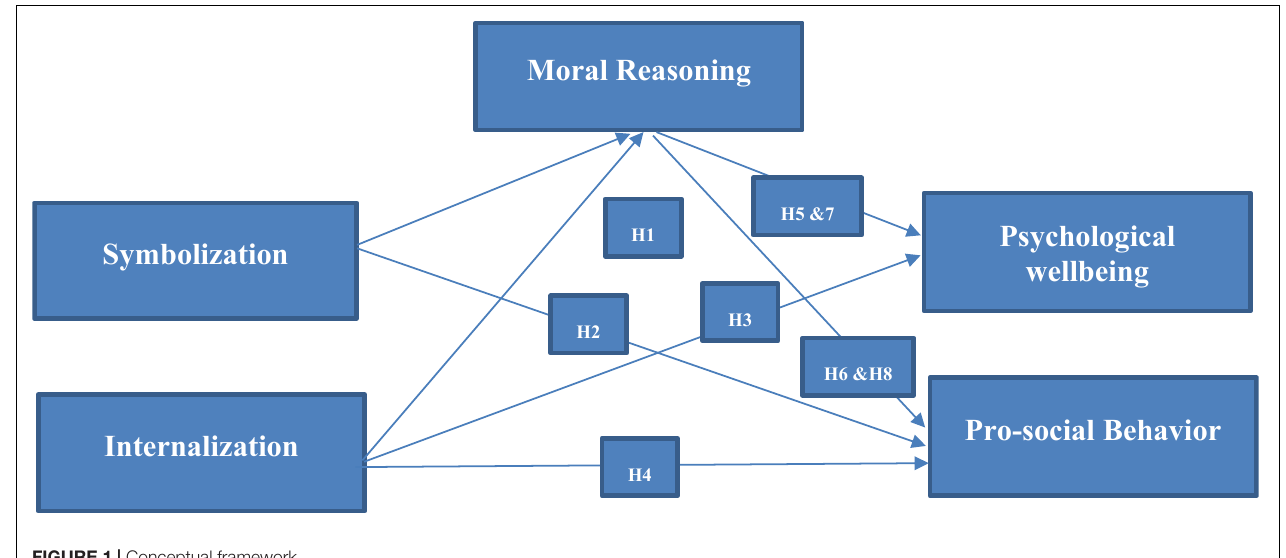
FIGURE 1 | Conceptual